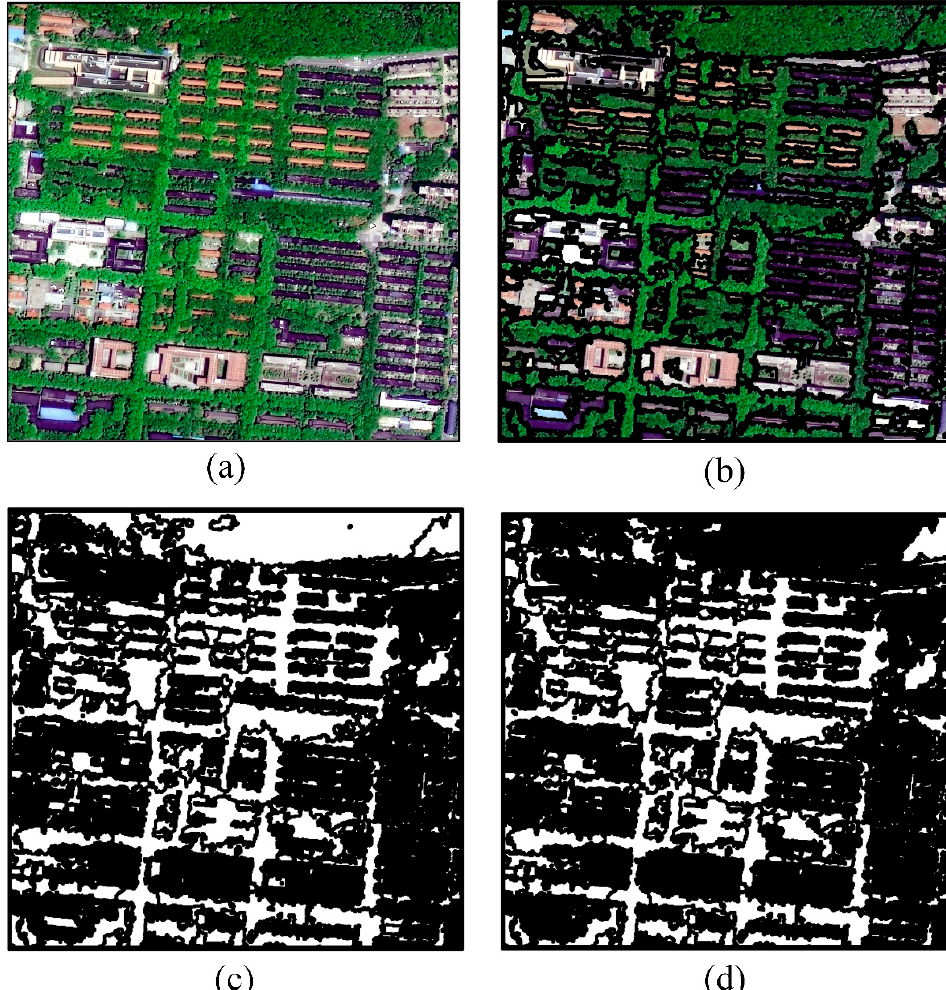
Figure 12. Experiments of vegetation detection: ( a ) The original sub-image from the study area (GF-2); ( b ) Result of image segmentation; ( c ) Classification result using Color VI; ( d ) Result of post-processing. The black pixels represent the objects of non-vegetation, or vegetation without obscuring effects in ( c ) and ( d ) while the white pixels represent the objects of the vegetation obscured ISAs.